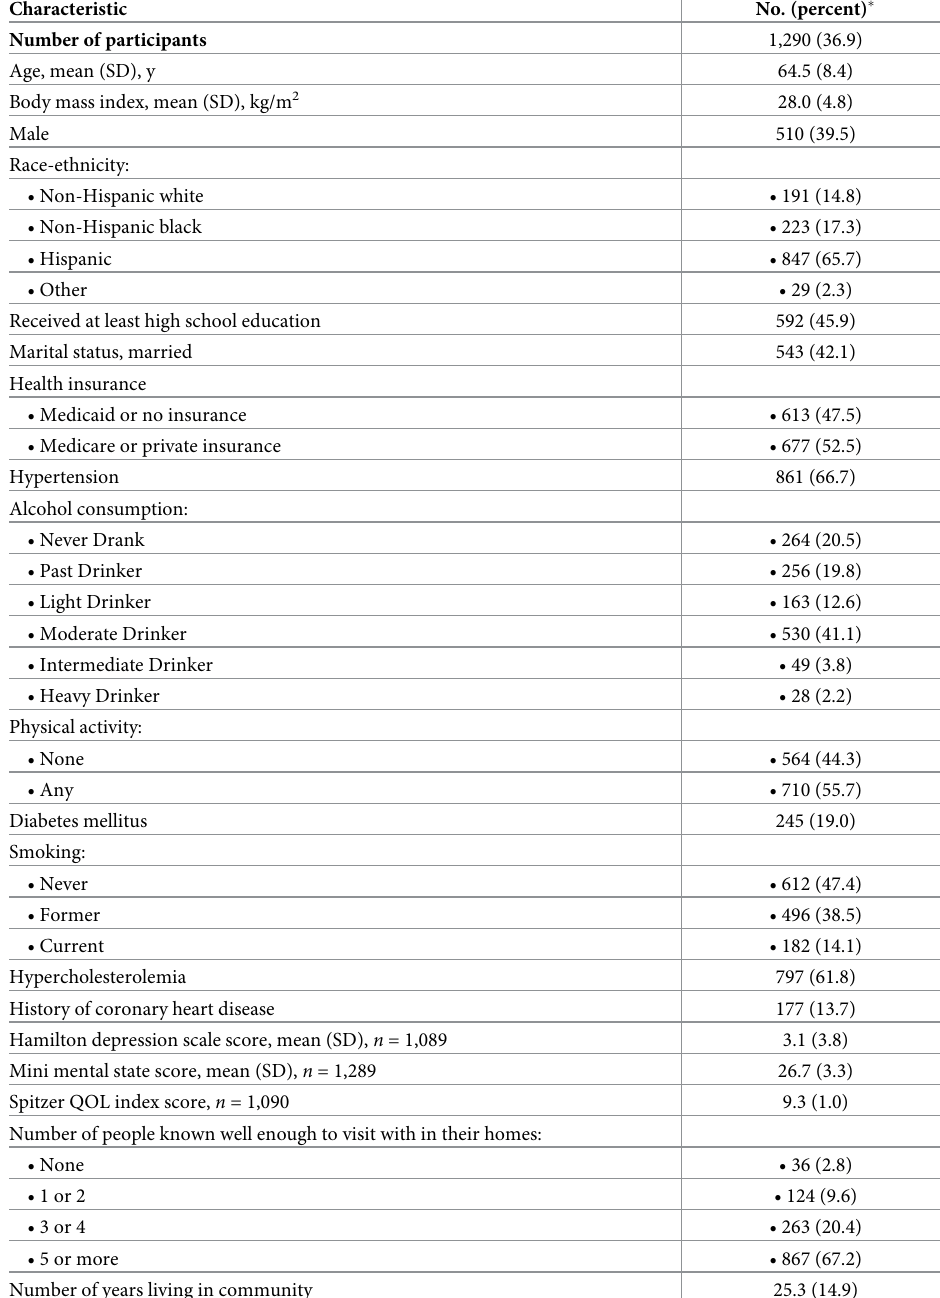
Table 1. Baseline characteristics of the